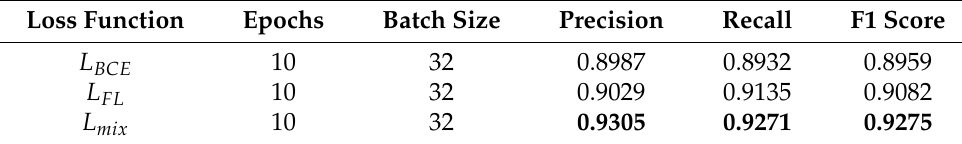
Table 3. Performance of SentiBERT-BiLSTM-CNN under different loss function settings.